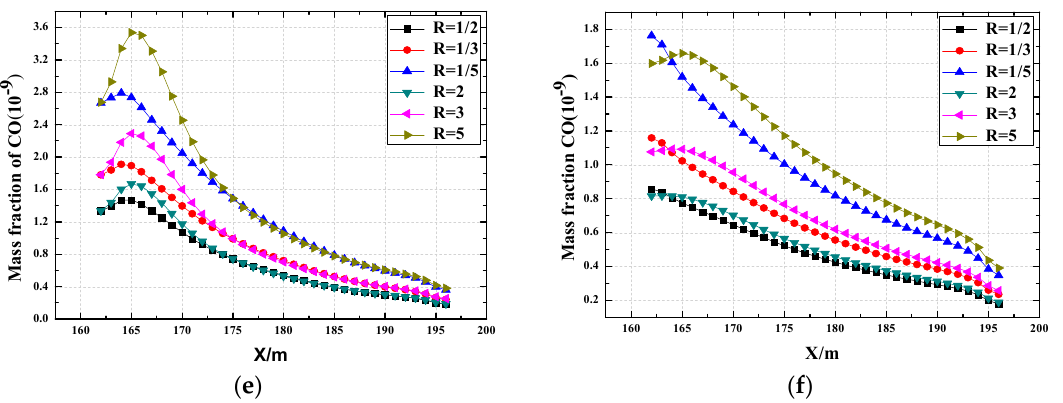
Figure 11 . CO concentration profile at different spatial positions at the wind speed 1.5 m/s: ( a ) X = 165 m; ( b ) X = 180 m; ( c ) X = 193 m; ( d ) Z = 1.5 m; ( e ) Z = 5 m; ( f ) Z = 10 m. Figure 11d–f represent the CO concentration profiles at horizontal heights of Z = 1.5 m, Z = 5 m, and Z = 10 m, respectively. At the lower horizontal height ( Z = 1.5 m), the concentration of CO is